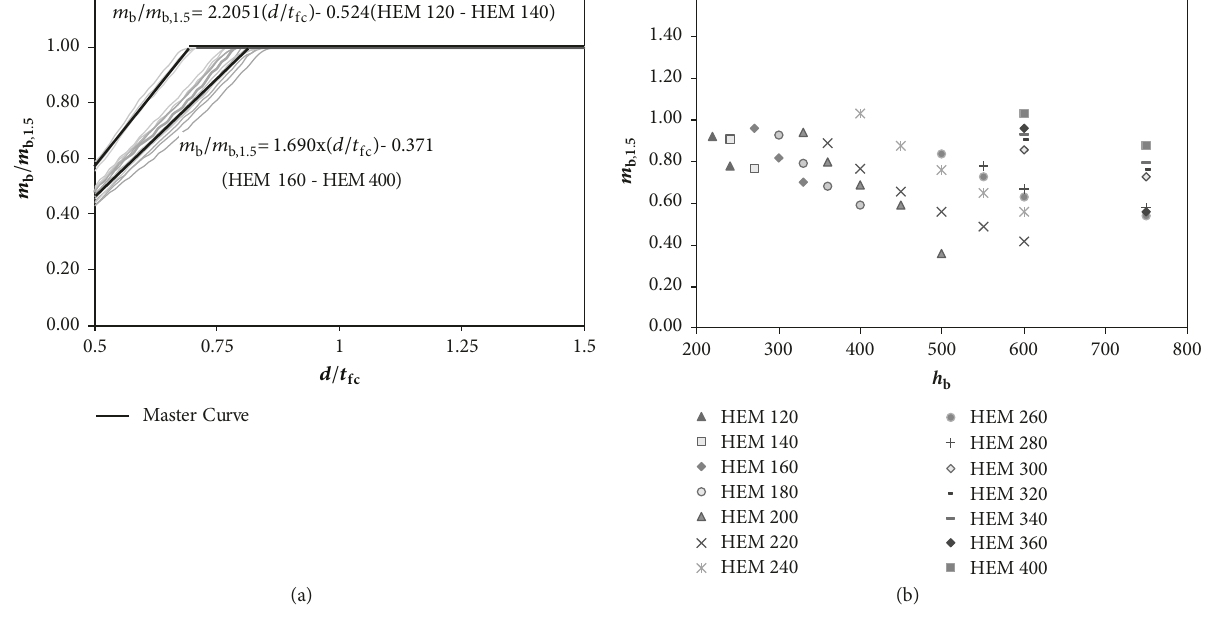
Figure 9: 𝑚 b /𝑚 b ,1.5 versus 𝑑/𝑡 fc relationship (a) and the shifting factor 𝑚 b ,1.5 (b).